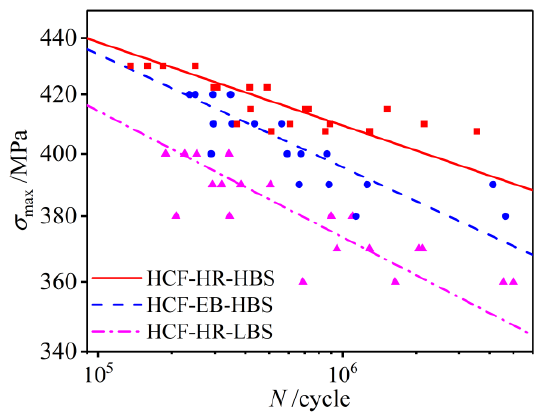
Figure 9. Comparison of the fatigue S-N curves for TC bimetallic steel with various interfacial conditions. Table 5. Comparison of the fatigue